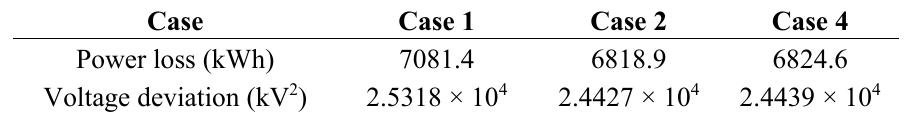
Table 5. Effects in modified IEEE 33-bus system with coordinated charging